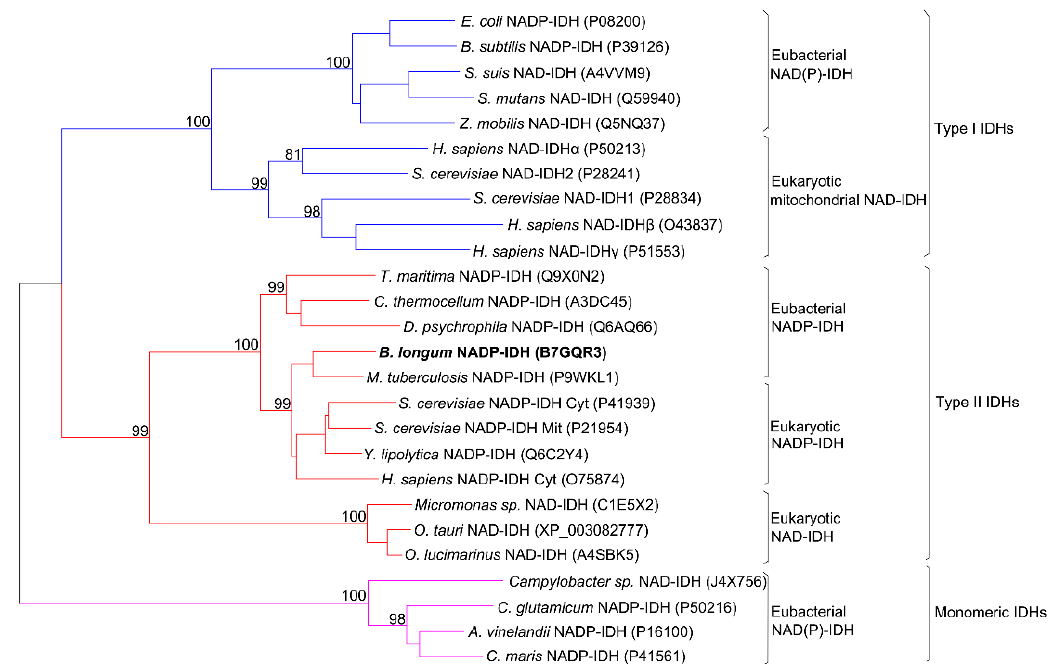
Figure 1. Phylogenetic tree of 26 isocitrate dehydrogenases (IDHs). A neighbor-joining tree with 500 bootstrap was created using MEGA 6.06. The GenBank accession numbers were noted in the parentheses.